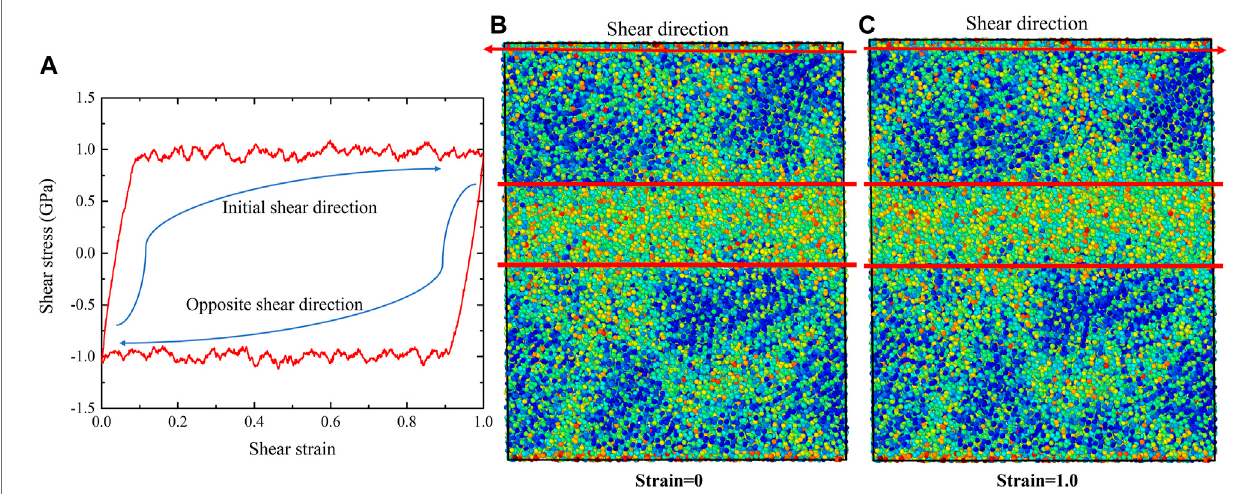
FIGURE 6 | The Bauschinger effect in G-phase after reaching to the state of plastic fl ow. (A) the shear-stress-shear-strain relationships of G-phase under cyclic shear deformation, (B) the fi nalstructure characterized using OP-8order parameterwhen shear alongopposite direction, and (C) the fi nal structure characterized using OP-8 order parameter when shear along initial